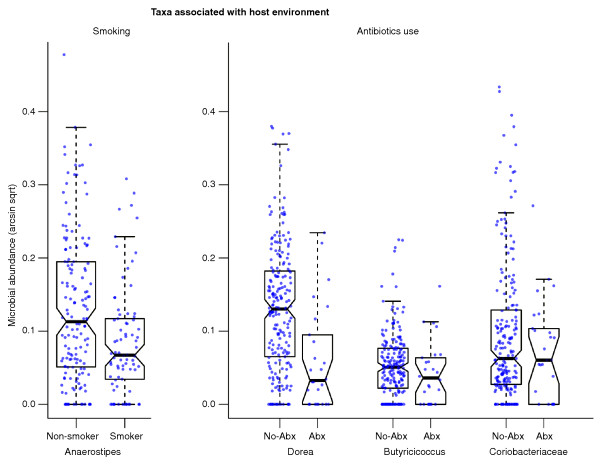
Select microbial clades significantly linked to host environment and treatment. Anaerostipes decreased significantly in the gut communities of smokers, and Dorea, Butyricicoccus, and Coriobacteriaceae were among the taxa most reduced in patients receiving antibiotics (Abx). These associations were significant even in a multivariate model accounting for sample biogeography and disease status. Sqrt, square root.